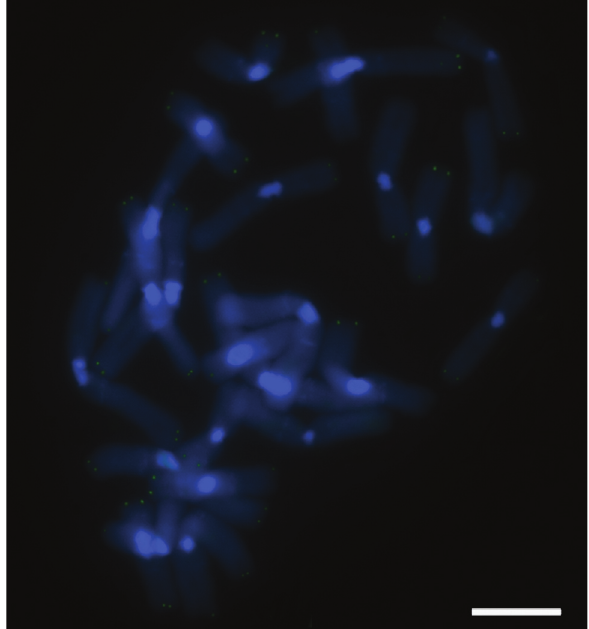
Figure 3 - FISH signals obtained with telomere PNA probes in the termi- nal regions of all chromosomes. Bar = 10 (cid:2)